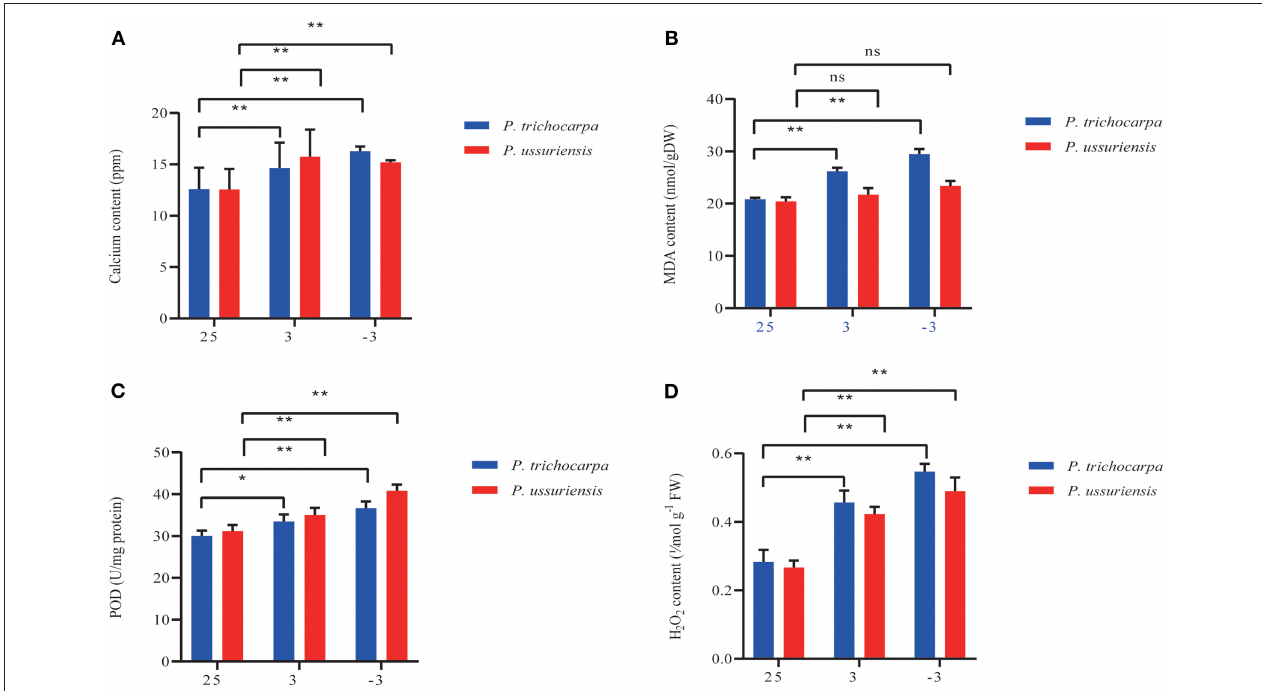
FIGURE 2 | Calcium and physiological indicators measurement in P. trichocarpa and P. ussuriensis. (A) Calcium content measurement using inductively coupled plasma (ICP) emission spectrometer (ICP-OES 5110 VDV, Agilent, USA). (B) MDA, (C) POD, and (D) H 2 O 2 content measurement. * P < 0.05; ** P < 0.01. ns denotes no significance.